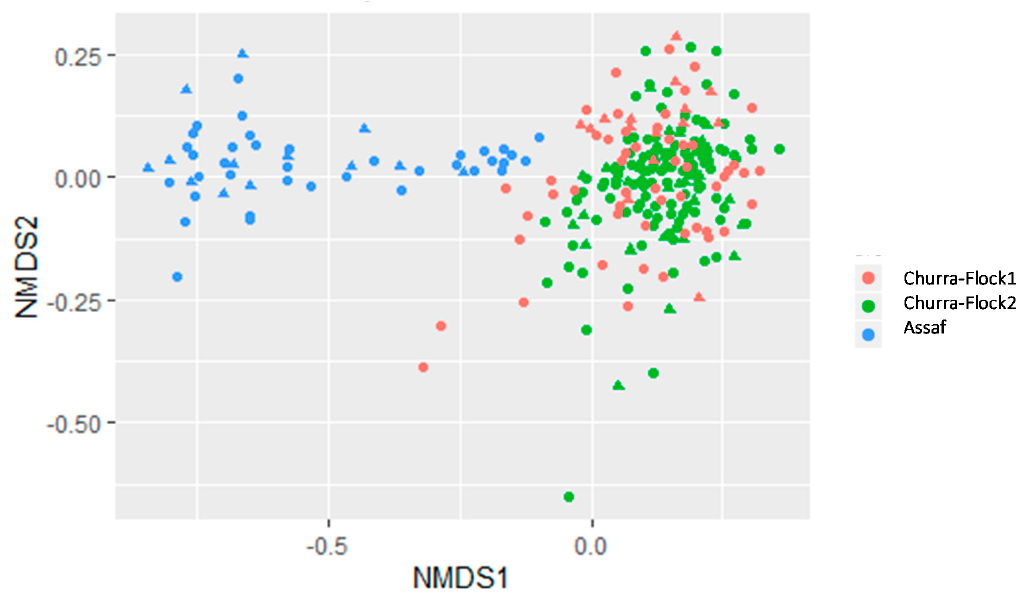
Figure 3. The similarity of bacterial communities between flocks. Non-metric Multidimensional Scaling (NMDS) ordination plot of the microbiota results obtained for sheep milk samples of Churra and Assaf sheep flocks. The distance between the samples is based on similarity in the amplicon sequences variant (ASV) composition of each sample calculated using the Bray-Curtis similarity index.